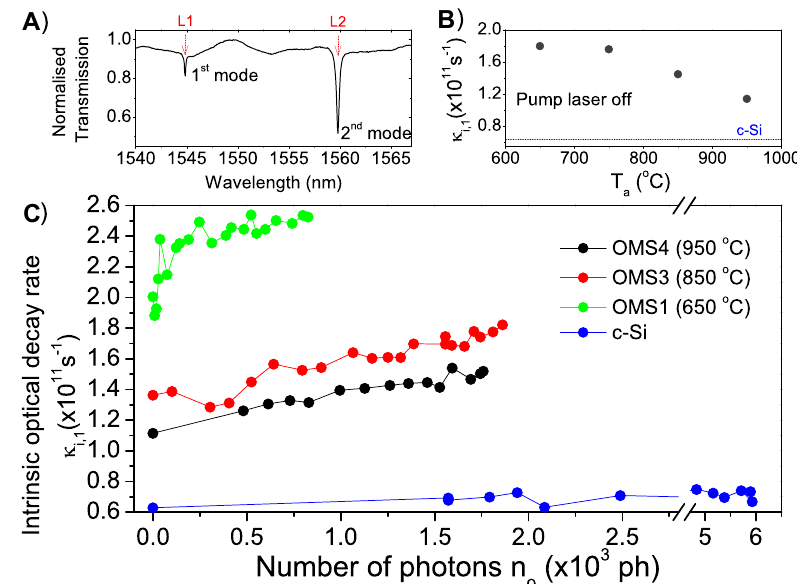
Figure 4: Optical transmission and intrinsic optical decay rate of the first-order mode. (A) Typicalopticaltransmissionspectrumof OMC (OMS4) under study displaying the first two optical modes excited with lasers L1 and L2, respectively, in a pump-and- probe experiment to determine the intrinsic optical decay rate κ i ,1 . (B) Intrinsic optical loss rate when the pump laser L2 is switched off, i.e., the second mode photon population is set to n o = 0, as a function of the annealing temperature of the nc-Si layers. The dashed horizontal line corre- sponds to the value measured in the c-Si reference sample. (C) Intrinsic optical loss rate of the fundamental mode as a function of the intracavity photon population. nc-Si, nanocrystalline silicon; OMC, nanoscale optomechanical